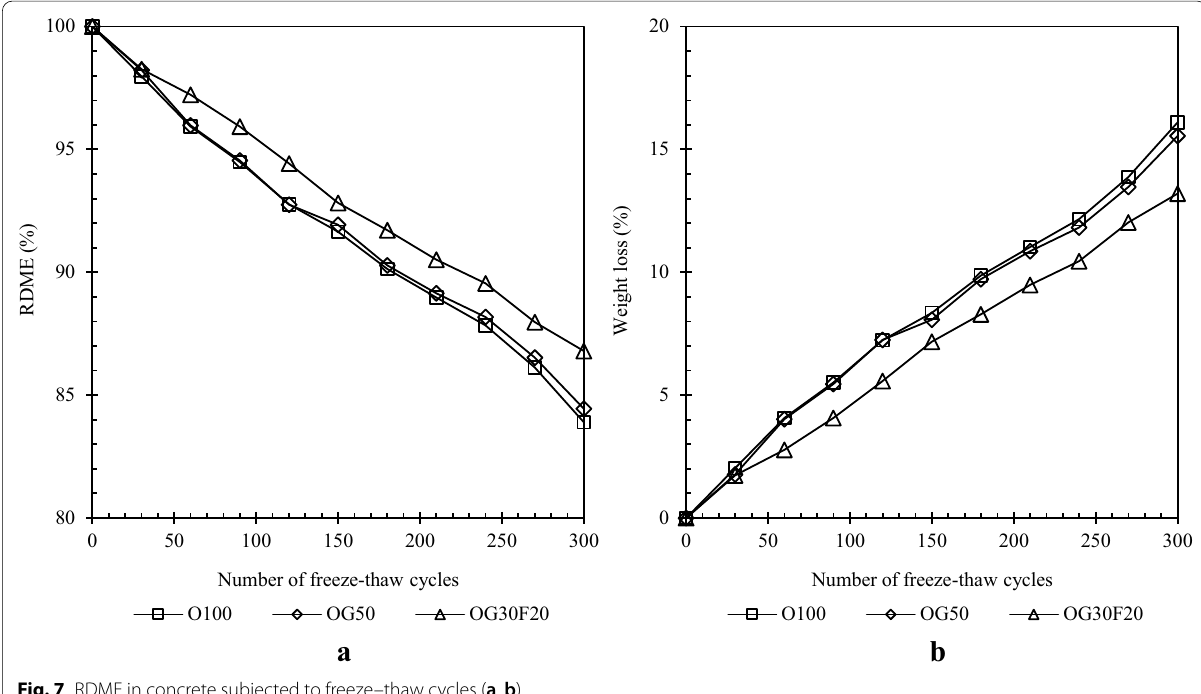
Fig. 7 RDME in concrete subjected to freeze–thaw cycles ( a , b